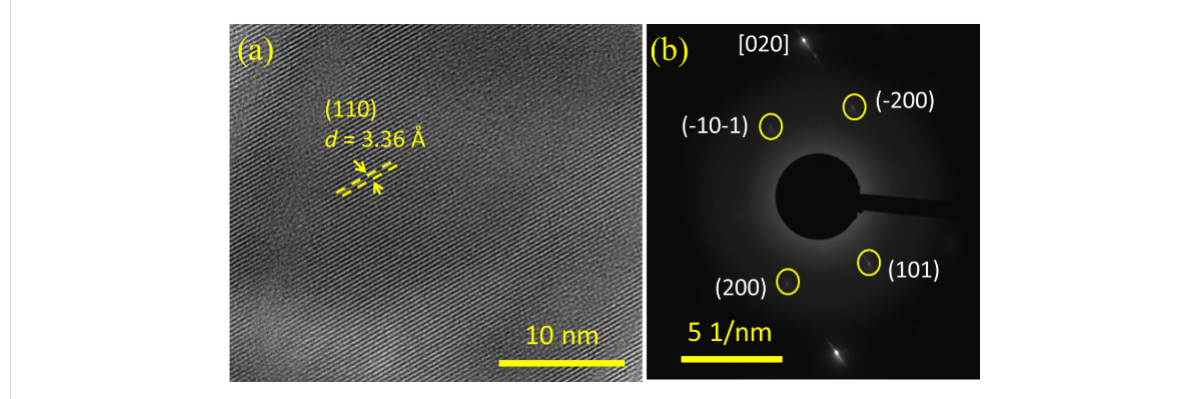
Figure 4: TEM images of belt-shaped NWs grown at 1000 °C. (a) HRTEM image of the NB. (b) SAED pattern of NBs obtained along the [020] zone axis.